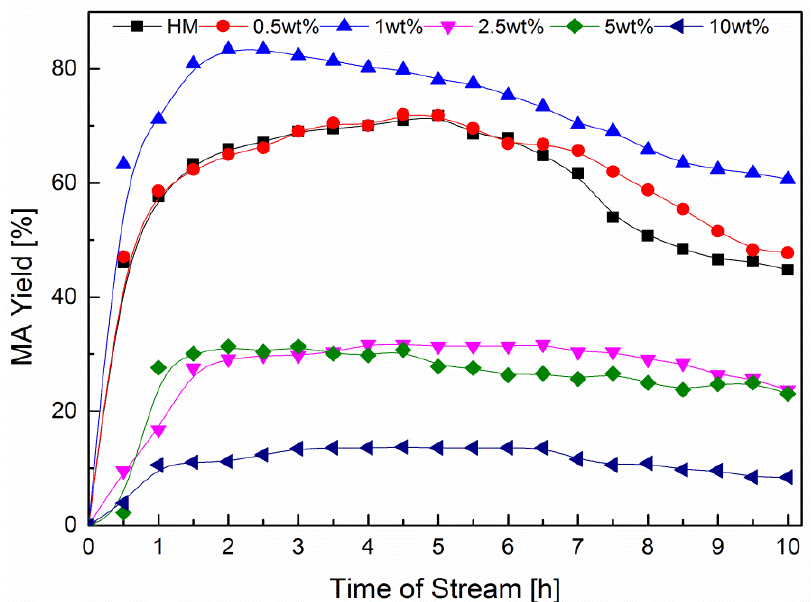
Figure 3. MA yields from DME carbonylation with HMOR and Cu-MOR catalysts with copper loadings from 0.5–10 wt%. Reaction conditions: 500 mg catalyst, 220 °C, 100 mL min − 1 gas flow of DME/CO/N 2 = 1.3/93.7/5.0%, 7 bar, GHSV = 6711 h − 1 . Data reported with an estimated error corresponding to ± 2%.